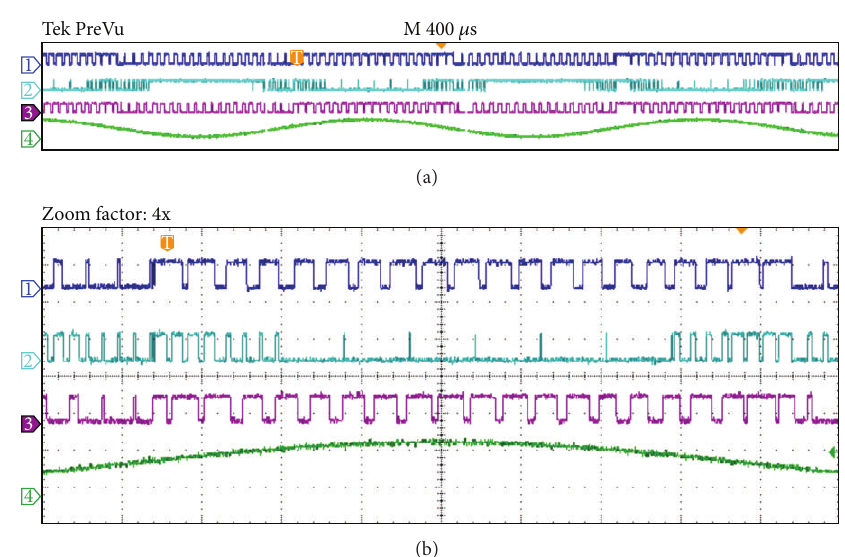
Figure 13: Control signals of the switches and sinusoidal reference. Top to bottom: control signal 𝑆 1 , 𝑆 3 , and 𝑆 2 , respectively, (5V/div each) and sinusoidal reference (2V/div each). Time: 400 𝜇 s/div; zoom time 100 𝜇 s/div.